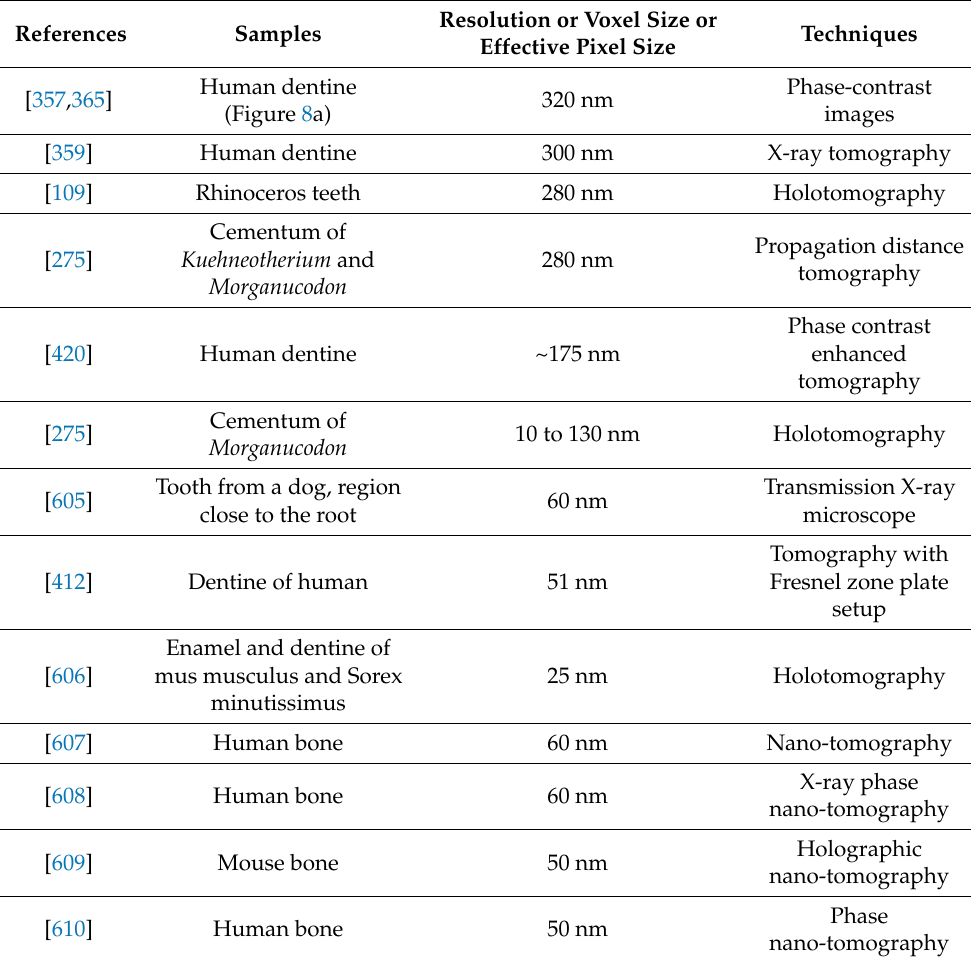
Table 2. Details of the 3D imaging carried out at high resolution on dental tissue and bone. Details of teeth analysed with high-resolution tomography and the technique used, as well as a few studies on